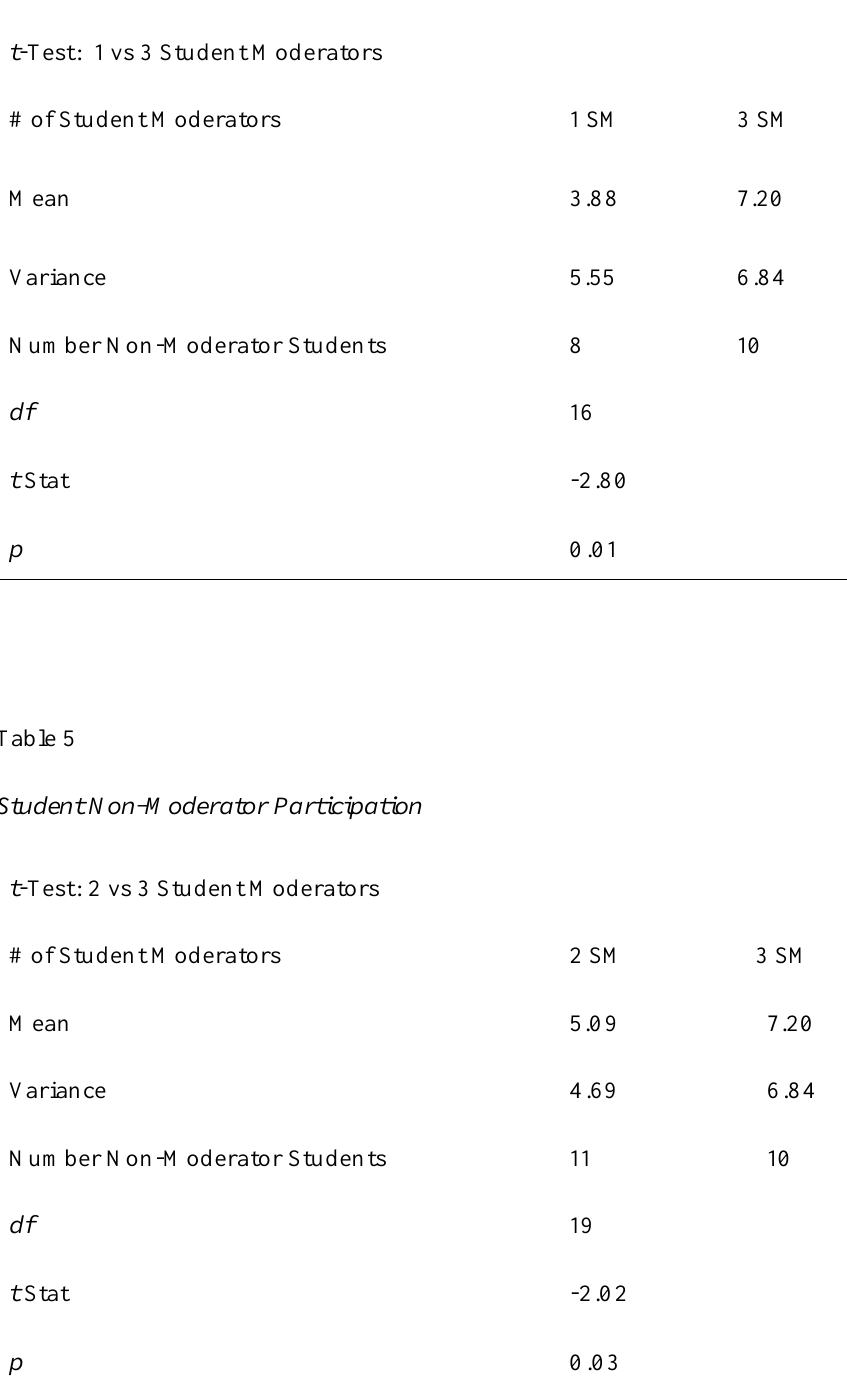
Student Non-Moderator Participation t -Test: 1 vs 3 Student Moderators